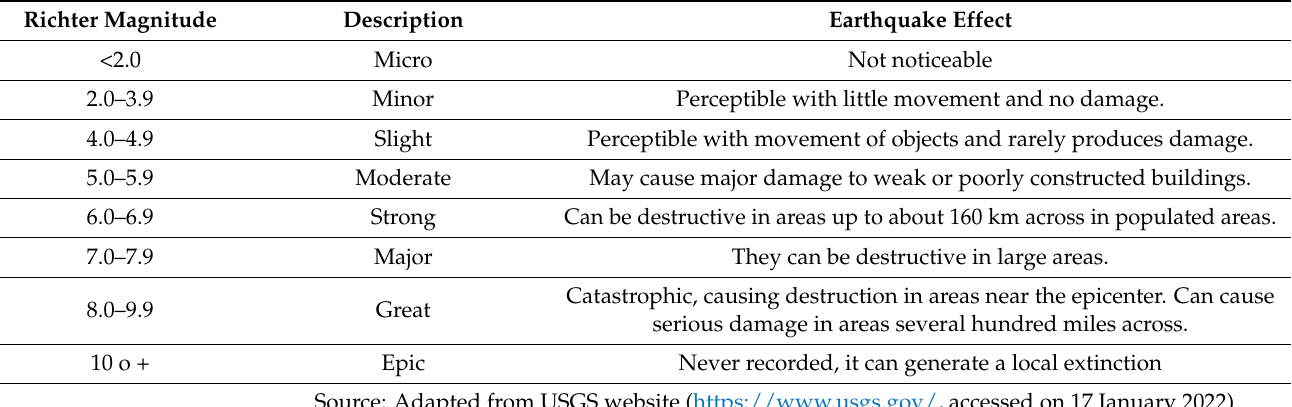
Table 1. Definition of magnitudes of Richter scale